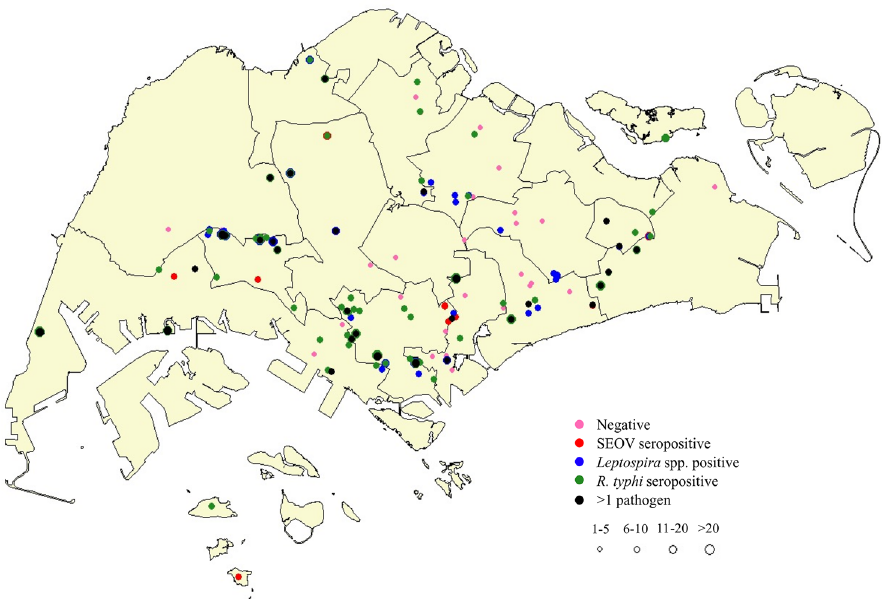
Figure 1. Spatial distribution of rodent trappings and prevalence of pathogens in R. norvegicus and R. rattus in Singapore, 2006–2008. Demarcations represent town councils. : rodents with no infection; : rodents seropositive for SEOV; : rodents positive for Leptospira spp.; : rodents seropositive for R. typhi ; : rodents positive for more than one type of pathogen. The number of rodents trapped was reflected by the size of the circle. Abbreviations : SEOV, Seoul hantavirus. Map created using the Free and Open Source QGIS.